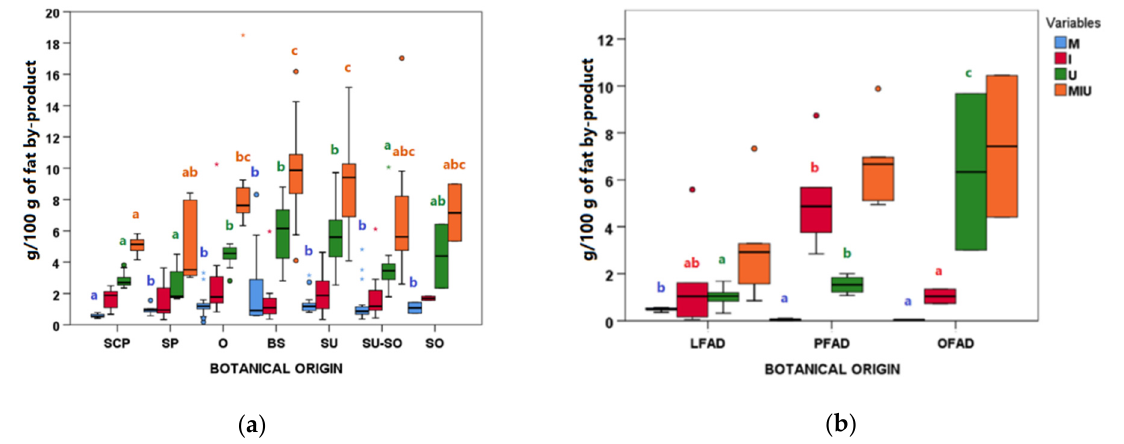
Figure 3. Boxplots for moisture (M), insoluble impurities (I), unsaponifiable matter (U), and the sum of them (MIU) according to botanical groups for ( a ) acid oils from chemical refining ( n = 79) and ( b ) fatty acid distillates from physical refining ( n = 13) (see Table 1 for botanical group abbreviations). Within each type of refining and variable, botanical groups bearing different letters (a–c) are significantly different according to Kruskal-Wallis test and post-hoc comparisons ( p ≤ 0.05).